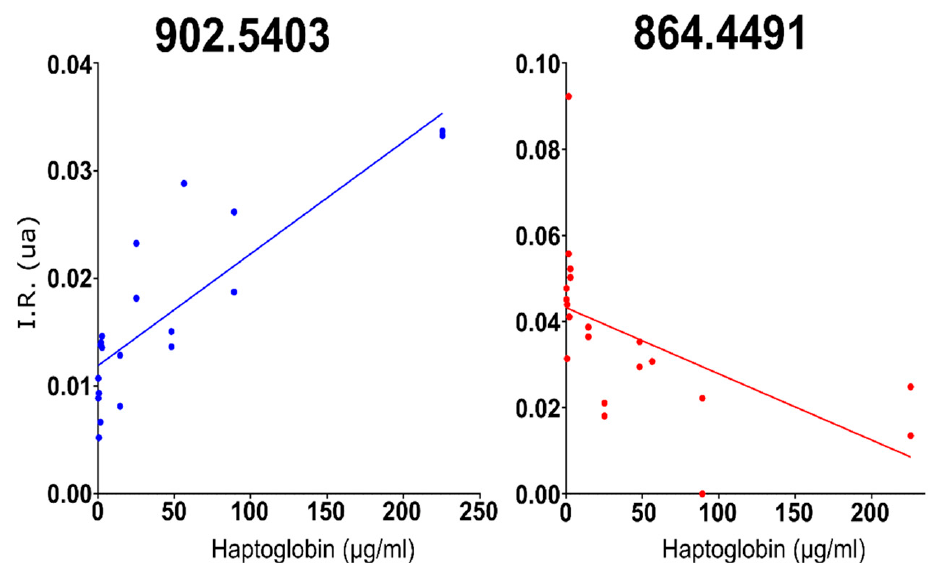
Figure 1. The two peaks with the best positive and negative correlations to haptoglobin concentration in milk: 902.5403 (in blue) and 864.449 (in red).